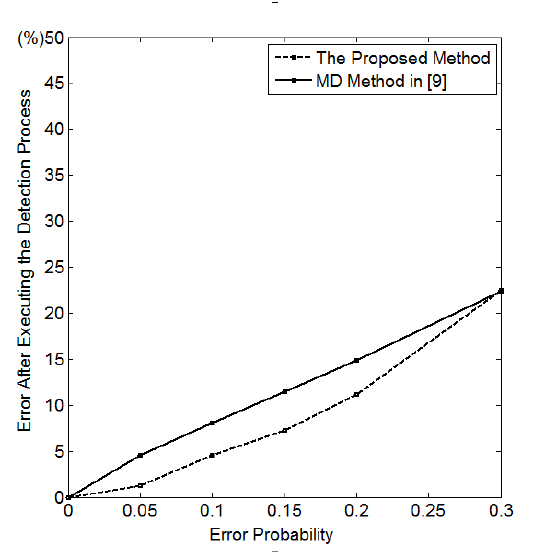
Figure 7. Comparison of Proposed Method and The Method in [9] On Probability of Errors after Executing the Detection Algorithm.